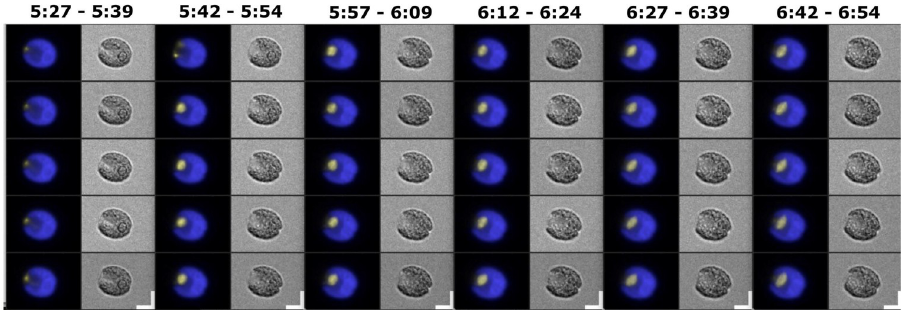
Fig 10. Live cell time-lapse of cdc20-1;EB1 : NG-TG cells. Live cell time-lapse acquired with microscopy method 1 (see Methods section). Each cell has a brightfield image (right), and a composite of EB1-NG signal in yellow and chloroplast autofluorescence signal in blue (left). Time indicated on top of each strip is hours and minutes after beginning of time-lapse. The indicated time corresponds to the top cell in each strip. Each subsequent cell going down is from an image captured every 3